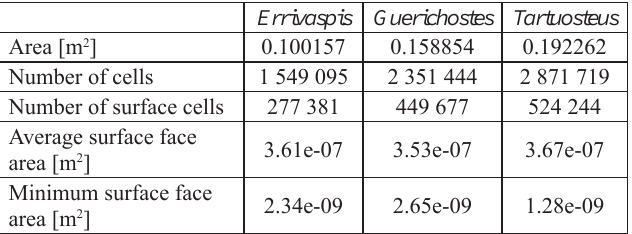
Table 1. The mesh statistics.